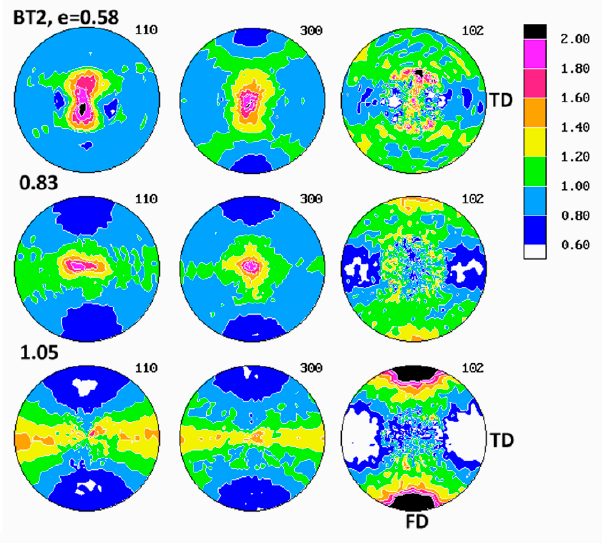
Figure 12. Selected normalized pole figures of the (110) (300) and (102) crystallographic planes (Form I) determined for samples of B2 homopolymer drawn in uniaxial tension to the true strain indicated.